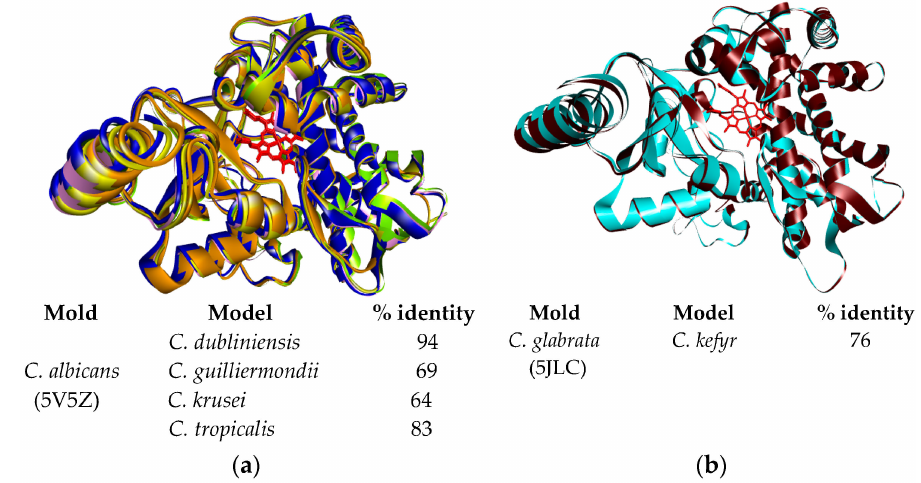
Figure 1. Flat ribbon representation of the CYP51 of Candida spp. (a) Overlapping of CYP51 Cd (purple), CYP51 Cgui (yellow), CYP51 Ck (orange), and CYP51 Ct (blue) with CYP51 Ca (PDB: 5V5Z) (green); (b) Overlapping of CYP51 Cke (brown) with CYP51 Cg (PDB: 5JLC) (cyan blue). The